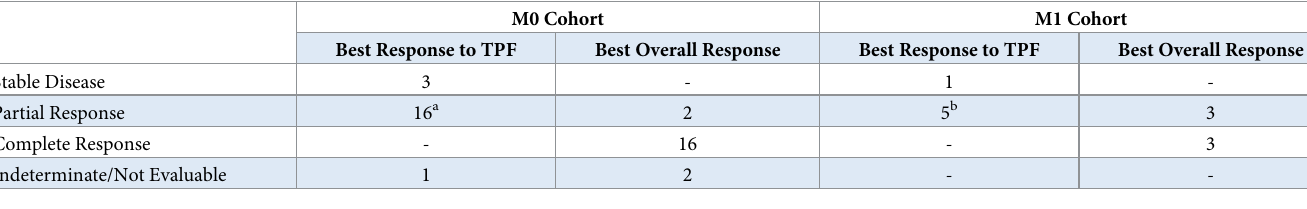
Table 2. Best response to TPF and best overall response in M0 and M1